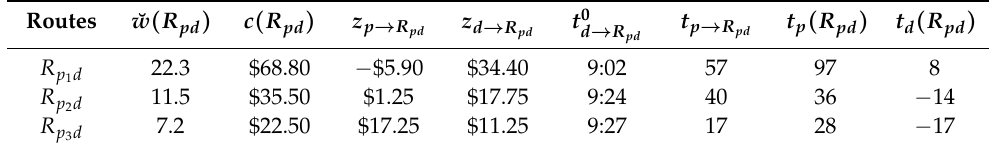
Table 2. The total time savings and costs estimated for passengers and driver sharing a trip through the joint route R pd